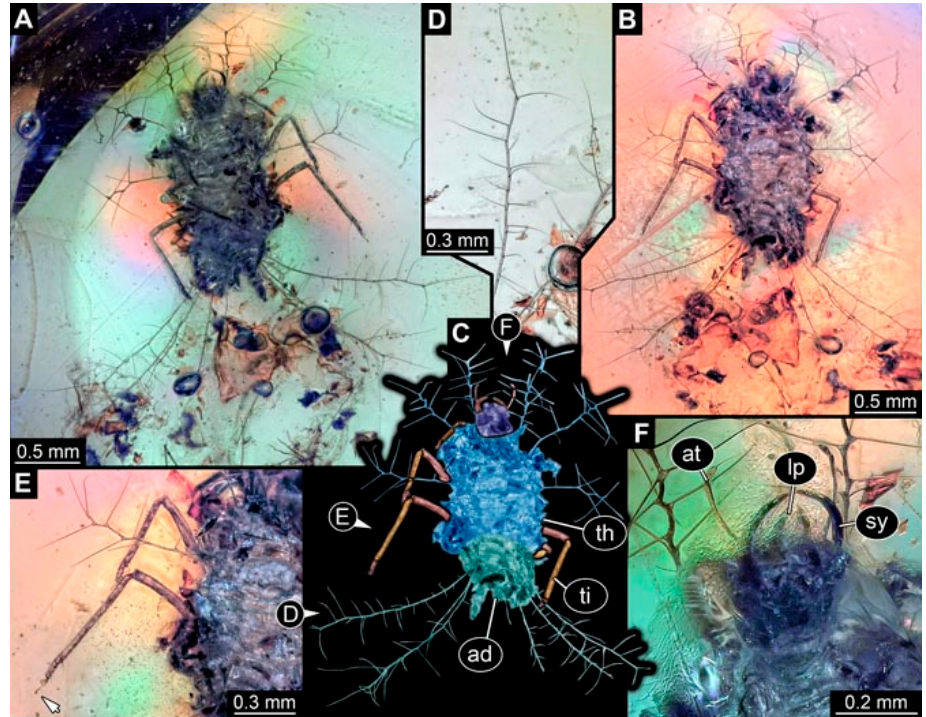
Figure 1. Specimen 4819 (BUB 3060); Myanmar amber. ( A ) Ventral view. ( B ) Dorsal view. ( C ) Dorsal view, colour-marked. ( D ) Close-up of protrusion in ventral view. ( E ) Close-up of trunk appendages with empodia (arrow). ( F ) Close-up of head capsule in ventral view. Abbreviations: ad = abdomen; at = antenna; lp = labial palp; sy = stylet; th = thorax; ti = tibia.